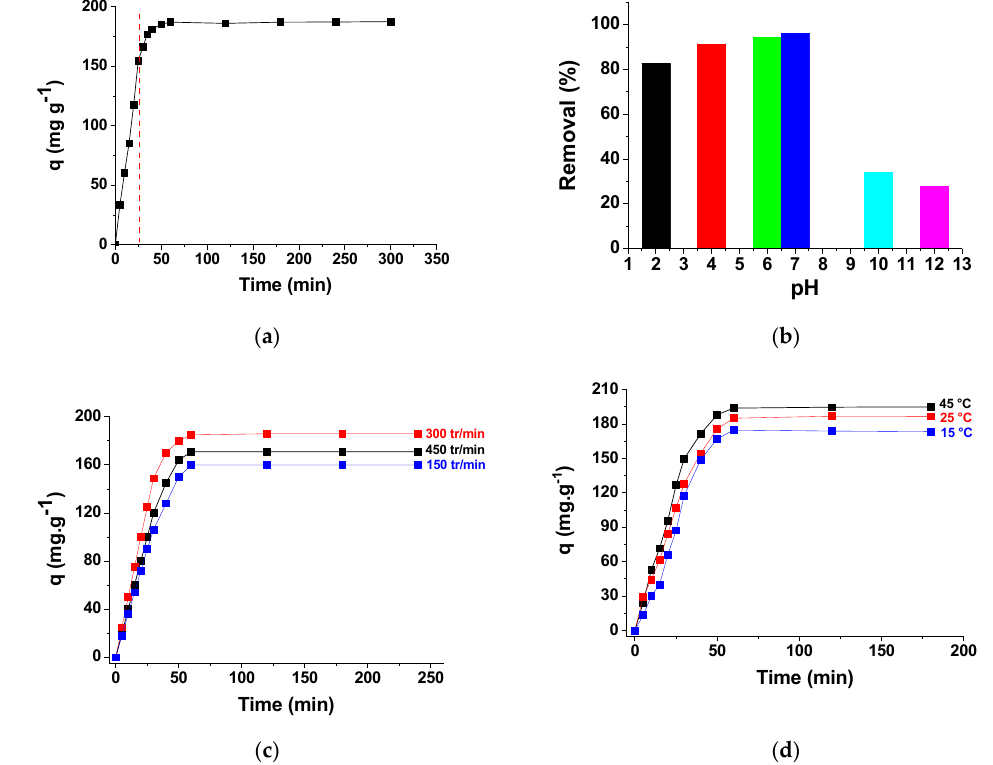
Figure 5. Contact time ( a ), pH ( b ) and stirring speed ( c ) effect on the Carmoisine (Az) removal using Ni/Zn LDH adsorbent (initial dye concentration = 50 mg L − 1 in 100 mL; sorbent mass = 30 mg; T = 25 °C; initial pH). ( d ) Kinetics of Az uptake by nanoadsorbents at various temperature (initial dye concentration = 50 mg L − 1 in 100 mL; sorbent mass = 30 mg; stirring speed = 300 rpm; initial pH).